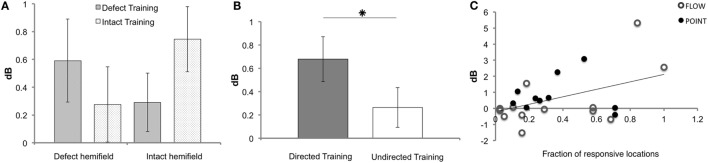
Results of Humphrey perimetry following each training round. (A) Mean sensitivity change in dB (± SEM) per hemifield. (B) Mean sensitivity change in dB (± SEM) for directed and undirected training combined for both hemifields. (C) Sensitivity increase measured with Humphrey perimetry (dB) after directed defect training as a function of number of non-responsive elements prior to training (A measurement). Note that patients J09, J10, J13, J14, and J22 were excluded for the Humphrey hemifield analysis (A), because this analysis requires three measurements with adequate fixation. For J14 and J22, data were included for the defect training round analyses (B,C), because their pre- and post-defect training perimetry was reliable.